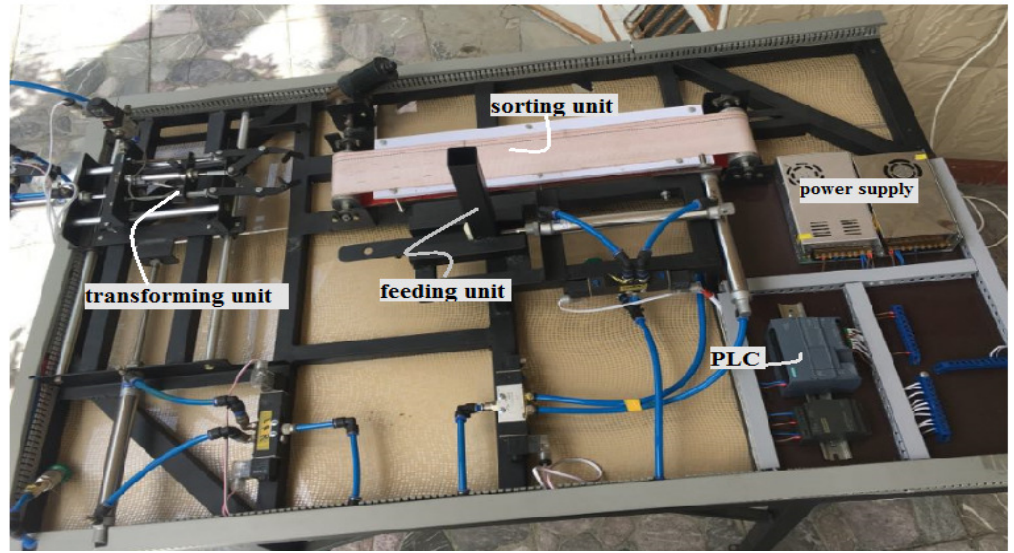
Fig. 8. The production line